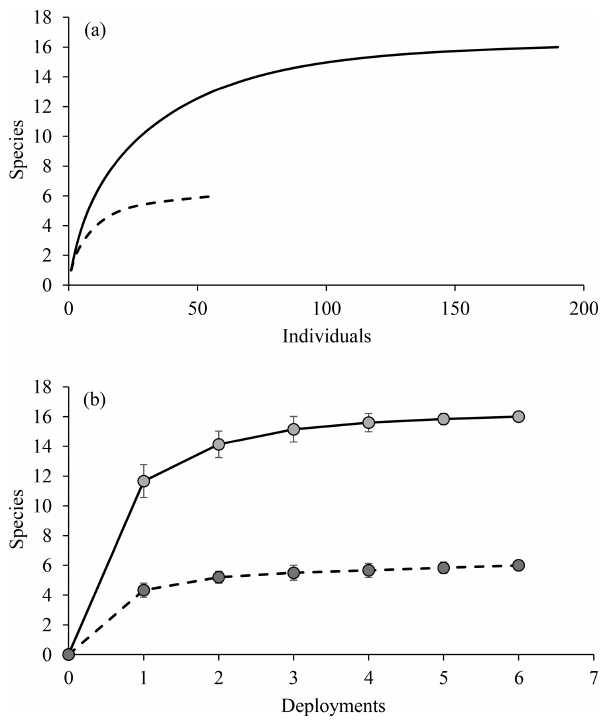
Figure 7. (a) Rarefaction and (b) species accumulation curves for baited camera observations. Solid lines represent all data, and dashed lines are fishes only (both based on MaxN